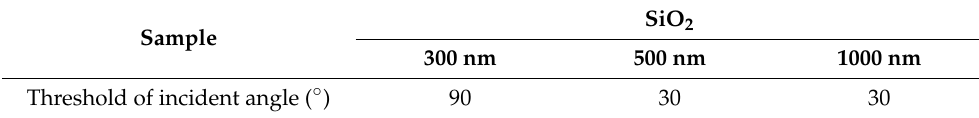
Table 3. Incident angle thresholds affected by the shadow effect on a SiO 2 substrate.